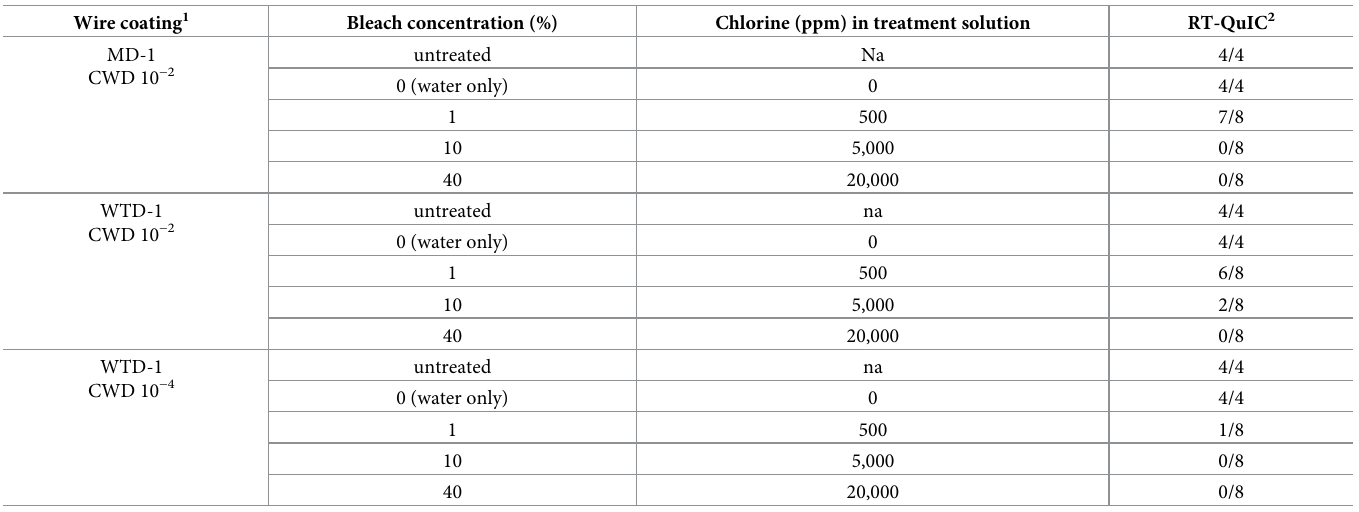
Table 3. Five-minute bleach treatments of CWD-coated